Question: Sum up the contents of this chart in one sentence.
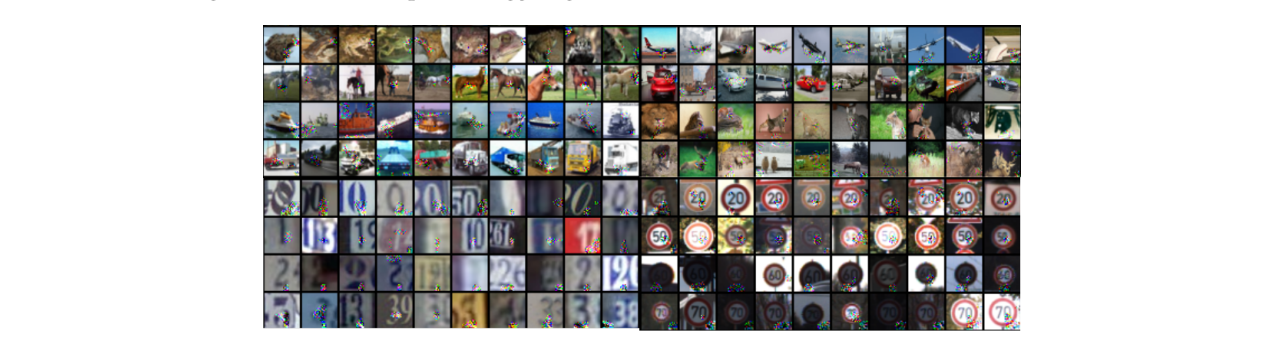
Answer: More examples of triggers generated with the contribution of 𝐿𝑃𝐼𝑃𝑆in the loss and the initialization of the trigger with the original values of the image.